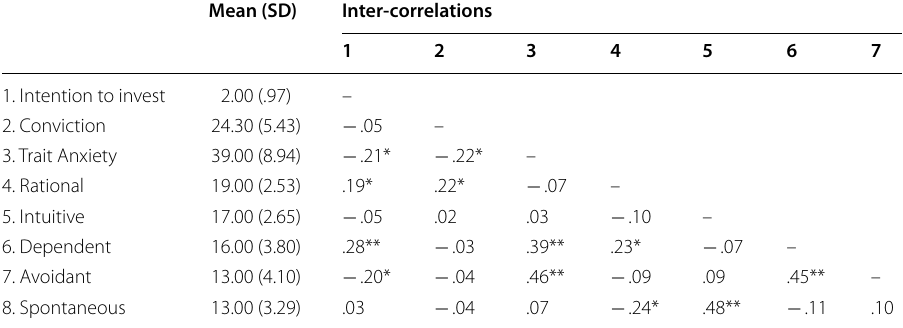
“Intention to invest” (score from 0 to 3); “conviction”(scores from 3 to 30) * p < .05, ** p < .01. N =